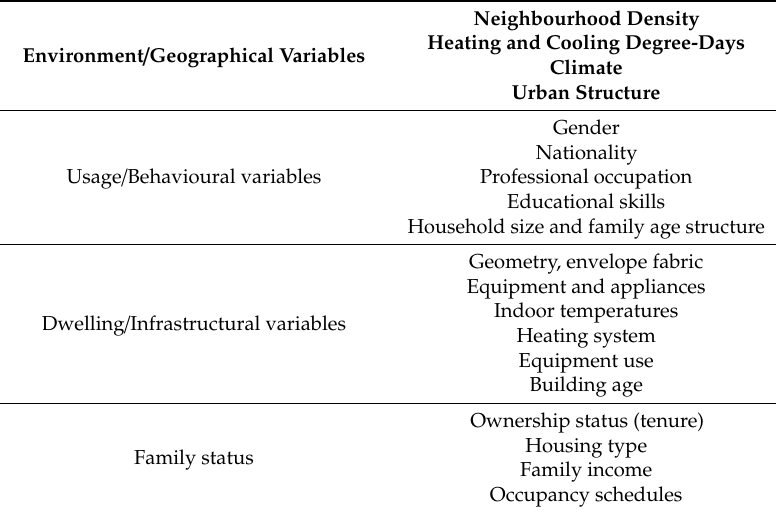
Table 2. Classification of variables driving electricity poverty.